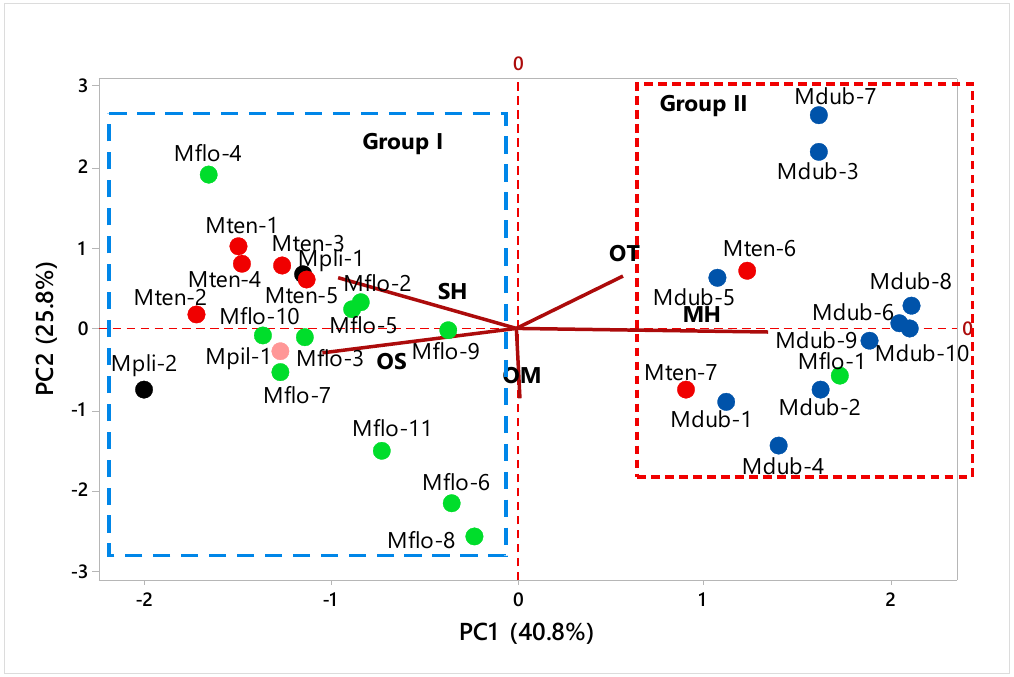
Figure 3. Principal component analysis (PCA) of Myrciaria volatile samples. Myrciaria floribunda (Mflo), M. tenella (Mten), M. dubia (Mdub), M. plinioides (Mpli), and M. pilosa (Mpil). Group I was characterized by the highest amounts of sesquiterpene hydrocarbons (7.7–92.1%) and oxygenated sesquiterpenes (4.6–88.2%), and minor amounts of monoterpene hydrocarbons (0–13.0%) and oxygenated monoterpenes (0–48.6%). Group II was characterized by the highest amounts of monoterpene hydrocarbons (39.6–93.8%), and minor amounts of oxygenated monoterpenes (0–27.1%) and sesquiterpene hydrocarbons (0.5–34.5%). Group I was composed of M. floribunda oil samples (Mflo-2 to Mflo-11), excluding Mflo-1. This oil sample was the only one that displayed a significant amount of monoterpene hydrocarbons (78.2%). Therefore, a new chemotype is being described in this work for the first time. Likewise, M. tenella (Mten-1 to Mten-5) oil samples were associated with group I, excluding the Mten-6 and Mten-7 oils. These two oil samples were characterized by significant amounts of monoterpene hydrocarbons (Mten-6, 47.9%; Mten-7, 53.5%). Moreover, the two samples of Myrciaria plinioides (Mpli-1 e Mpli-2) were also included in group I by displaying low chemical variability, characterized by the presence of oxygenated sesquiterpenes (Mpli-1, 88.2%; Mpli-2, 24.1%). Group II was composed of all oil samples of Myrciaria dubia (Mdub-1 to Mdub-10) and some oils of M. tenella (Mten-6 and Mten-7) and M. floribunda (Mflo-1), characterized by significant amounts of monoterpene hydrocarbons (39.6–93.8%). 2.3. Biological Activities of Myrciaria Species Some studies have reported the biological properties of Myrciaria essential oils. The M. tenella leaf oil, rich in E -caryophyllene (25.1%), spathulenol (9.7%), globulol (5.9%), and α -cadinol (5.2%), showed an anti-inflammatory activity on chemotaxis assay, at the doses of 9 mg/mL, with 93% neutrophils inhibition [32]. Moreover, the M. plinioides oil, with significant contents of spathulenol (21.1%), caryophyllene oxide (15.2%), isolongifolan-7- α -ol (9.8%), mustakone (5.6%), and α -cadinol (5.4%), exhibited antileishmanial activity against promastigote forms of Leishmania amazonensis (IC 50 14.16 μ g/mL) and Leishmania infantum (IC 50 101.50 μ g/mL) [36].